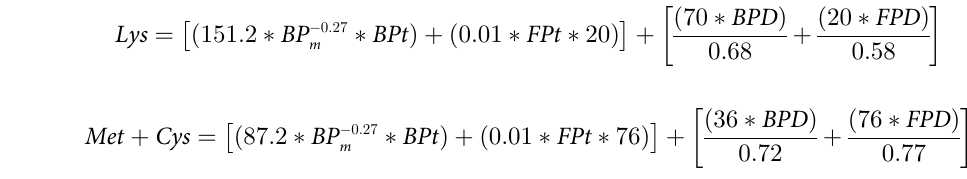
Based on these results, a validation procedure was performed, considering the efficiency of uti- lization determined with multiple linear regression. The factorial models described by Sako- mura and colleagues [4] were employed in using one efficiency of utilization (whole body) as described previously [2, 14, 27], or two efficiencies of utilizations, feather-free body and feather, determined in this study (adjusted factorial model). The requirements predicted by the equations are shown in Table 6.